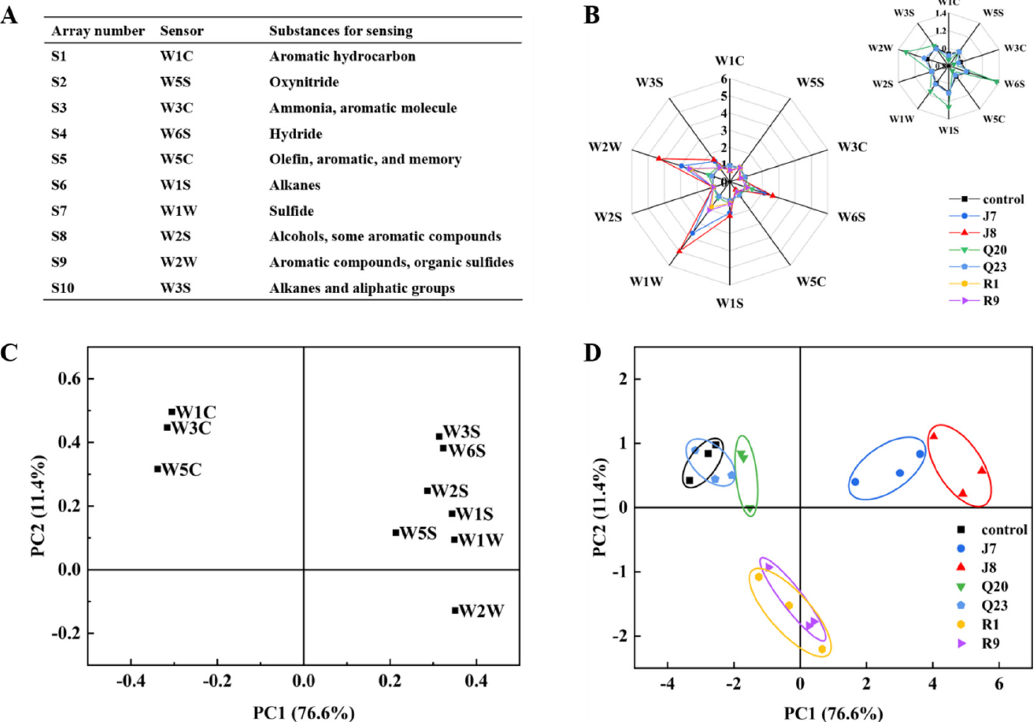
Figure 4. Effects of different spoilage bacteria on E-nose responses to chicken samples at the end of storage. Response substances of each E − nose sensor ( A ), radar plot ( B ), loading plot ( C ), and principle component analysis ( D ) of chicken samples incubated with different bacteria.